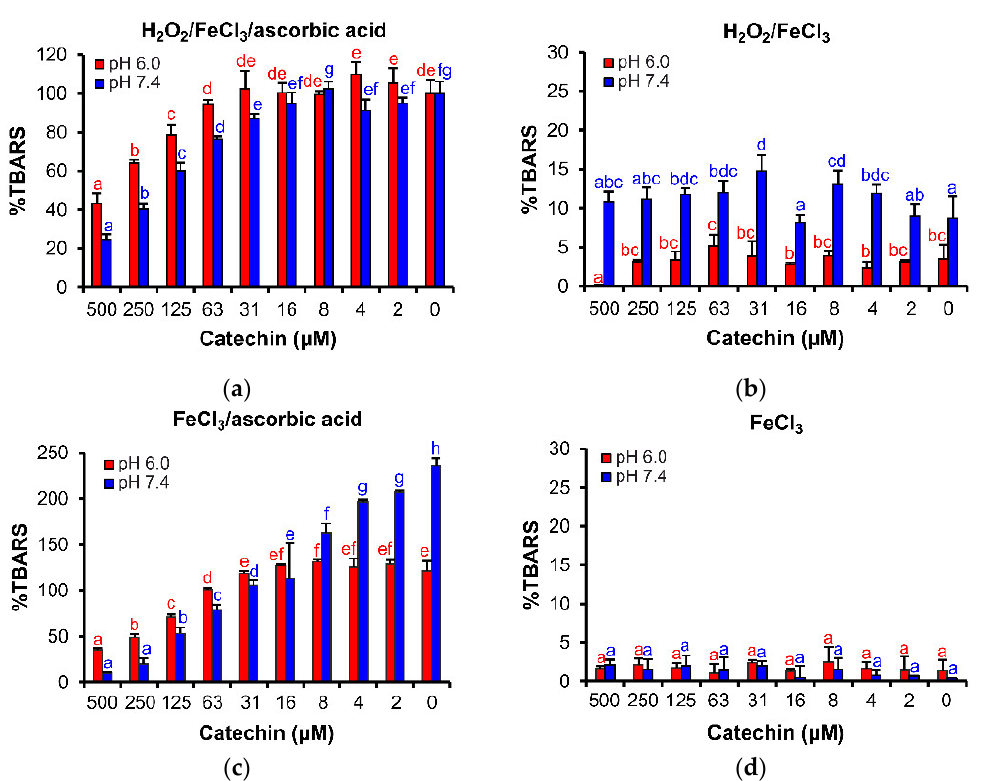
Figure 6. Inhibition effects of (±)-catechin on TBARS formation in the site-specific deoxyribose degradation assay: ( a ) H 2 O 2 /FeCl 3 /ascorbic acid, ( b ) H 2 O 2 /FeCl 3 , ( c ) FeCl 3 /ascorbic acid, and ( d ) FeCl 3 . The bars represent the mean of three replicates (± SD). Letters above the bars indicate significance levels (ANOVA with 95% Duncan’s post hoc test). TBARS: thiobarbituric acid reactive species, SD: standard deviation.